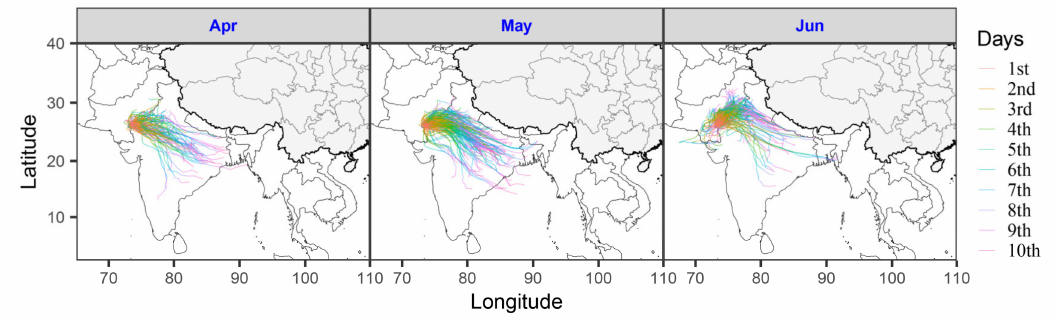
Figure 3. Simulated forward trajectories started from a point at the border between Pakistan and India (27 ◦ N, 70 ◦ E) in last 5 years (2015–2019). These trajectories were calculated by the Hybrid Single-Particle Lagrangian Integrated Trajectory (HYSPLIT)